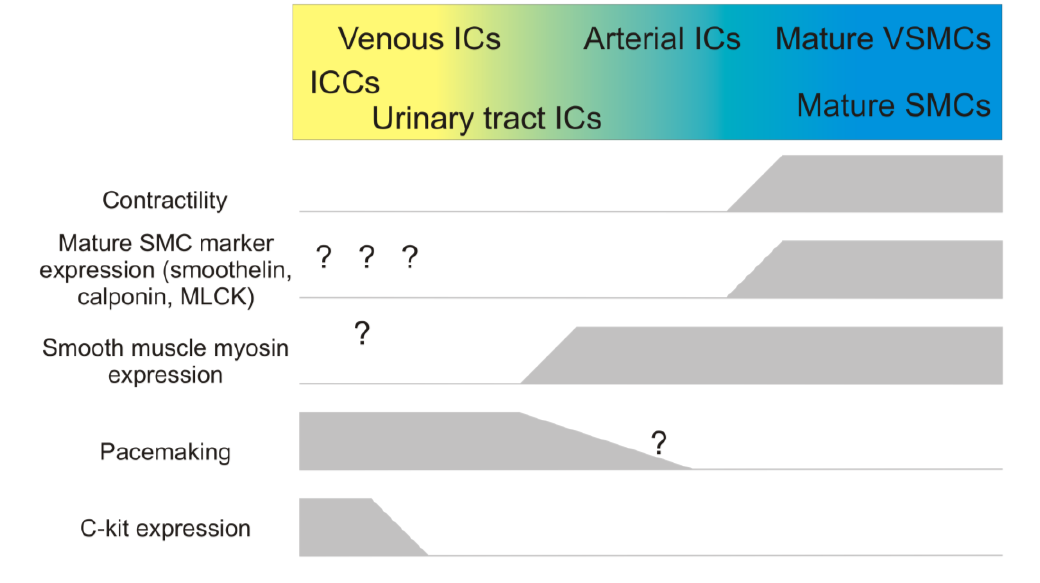
FIGURE 4. Diagram showing the possible spectrum of smooth muscle cell phenotypes and their